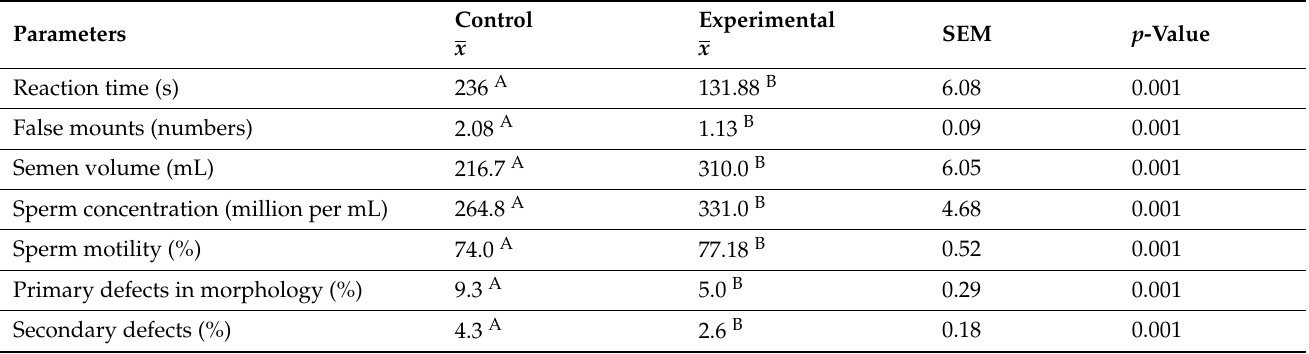
Table 2. Comparison of the sexual behavior and quality parameters of fresh semen of boars fed diets top-dressed with linseed oil ethyl esters (mean, n = 6/group, SEM, p -value).